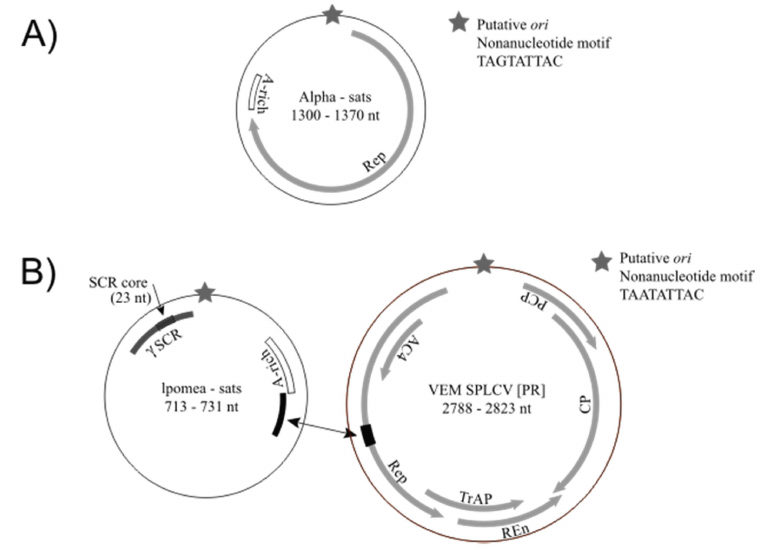
Figure 1. Schematics depicting general genome organization and features observed in novel alphasatellites ( A ) and Ipomoea satellites ( B ) detected during this study. All genomes are characterized by a putative origin of replication ( ori ) marked by a stem-loop structure containing a conserved nonanucleotide motif. Alphasatellites encode a replication-associated protein (Rep) and exhibit an adenine-rich (A-rich) region. Ipomoea satellites do not exhibit any coding regions; however, these gammasatellites contain an A-rich region as well as a conserved region ~100 nt long shared among various gammasatellites ( γ SCR). The γ SCR contains a 23 nt stretch where all gammasatellites reported to date share high similarities with betasatellites, named here the satellite common region (SCR) core. Some Ipomoea satellites from Puerto Rico share high identities with a 66 nt stretch (highlighted in black) found within the rep gene of sweet potato leaf curl virus (SPLCV) genomes detected in the same